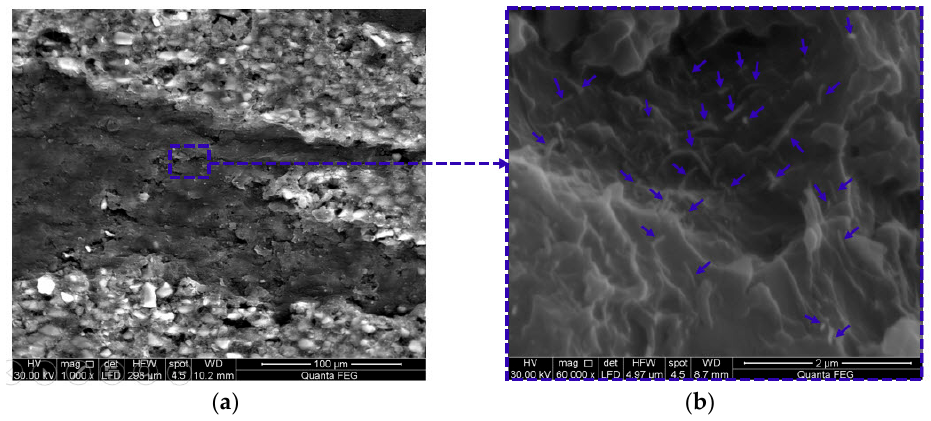
Figure 3. FESEM images for ( a ) 2.0 wt % CNFs/glass fiber reinforced polymer (GFRP) coupon and ( b ) a close view of well-dispersed 2.0 wt % CNFs in epoxy matrix and the blue arrows mark some of the embedded CNFs.